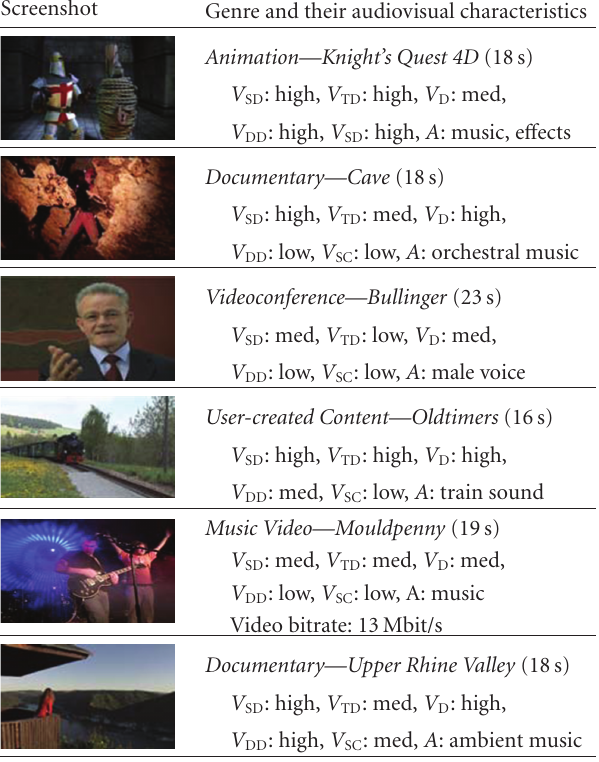
V SC : amount of scene cuts, and